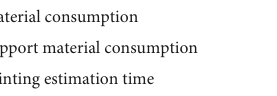
solution-soluble material utilized when printing small features.